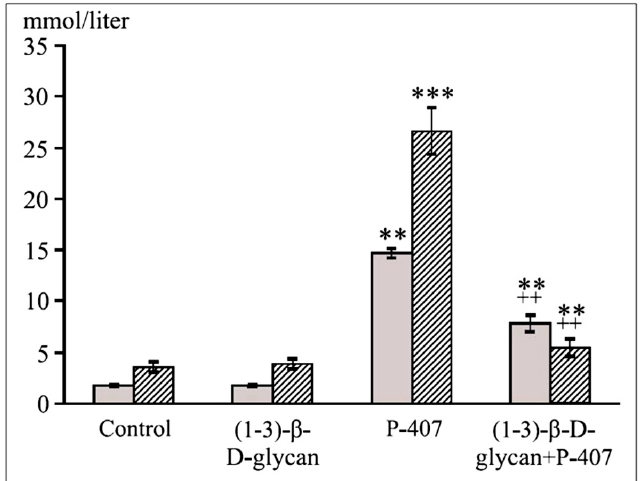
Figure 3. Hypolipidemic effects of (1–3)- β - D -glucan. A significant ( p < 0.01) decrease in serum